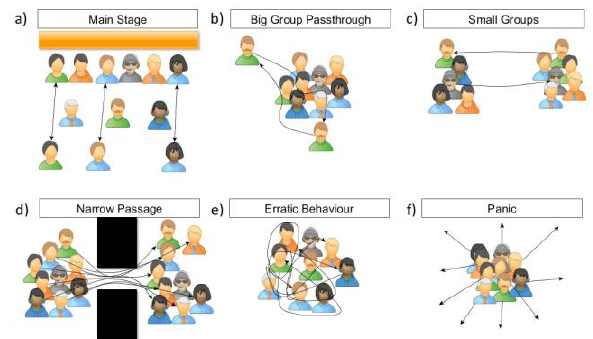
Figure 2. Different crowd scenarios performed by the group of volunteers during the flight campaign.